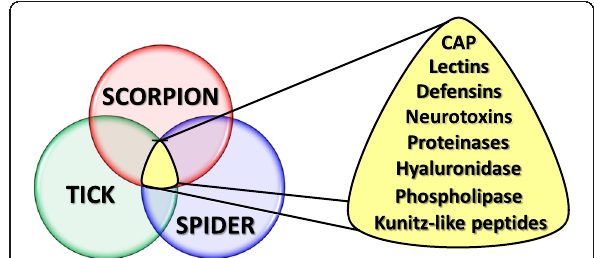
Fig. 1 Venn diagram highlighting the protein families presented in tick saliva and scorpion/spider venoms. Catabolite activator protein (CAP), defensins, hyaluronidase, Kunitz-like peptides (serine proteinase inhibitor), neurotoxins, lectins and phospholipase are some of the compounds shared among these arthropods